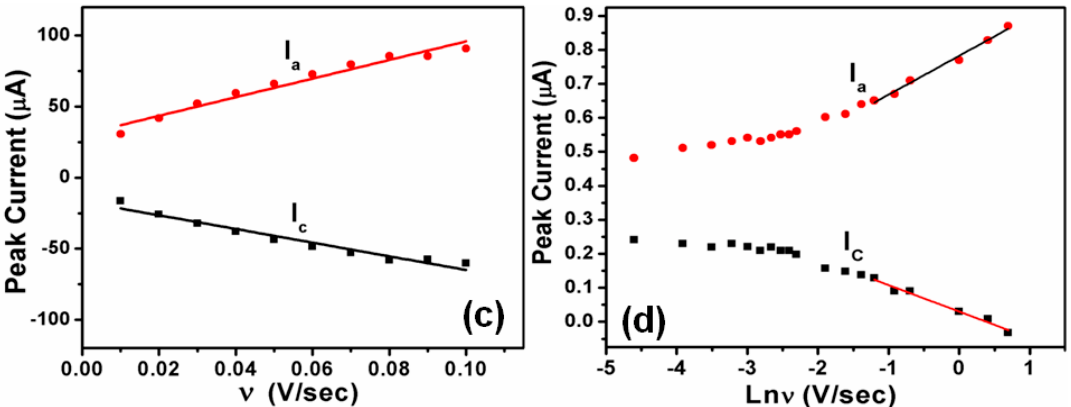
Figure 11. ( a ) Cyclic voltammograms obtained for ZnO nanoparticles/GC electrode in 0.1 M PBS (pH = 7.4), containing 5 mM hydroquinone at various scan rates of 10, 50, 70, 90, 100, 200, 300, 400, 500, 1000, 1500, and 2000 mV/s; ( b ) Plot for the anodic and cathodic peak current versus the square root of the scan rates in the same solution; ( c ) Plot for the anodic and cathodic peak current versus the scan rates in same solution; and ( d ) Plot for the anodic and cathodic peak current versus the natural Log of scan rates in the same solution. Adapted figure from [91] with permission from copyright (2014), American Scientific Publishers (Los Angeles, CA, USA).